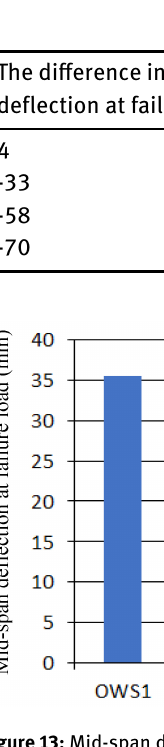
Figure 13: Mid-span deflection at failure loads for all specimens.